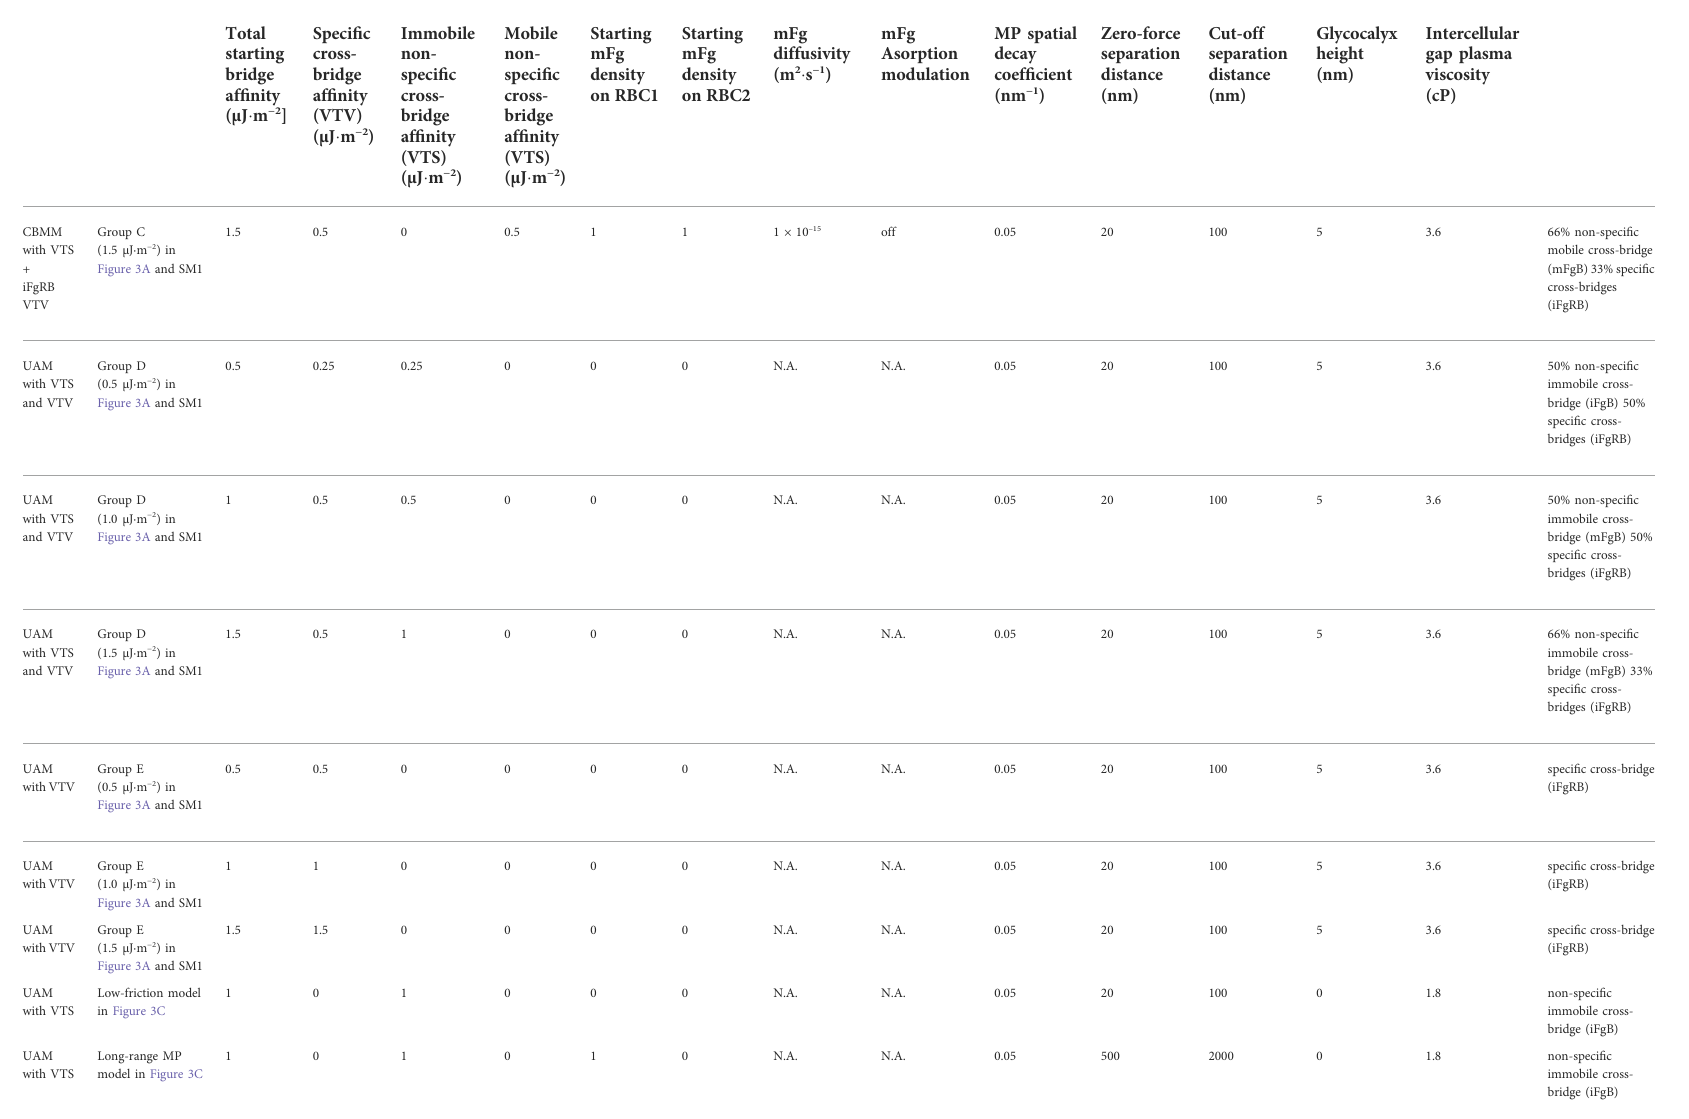
TABLE 2 ( Continued ) Simulation parameters for doublet formation